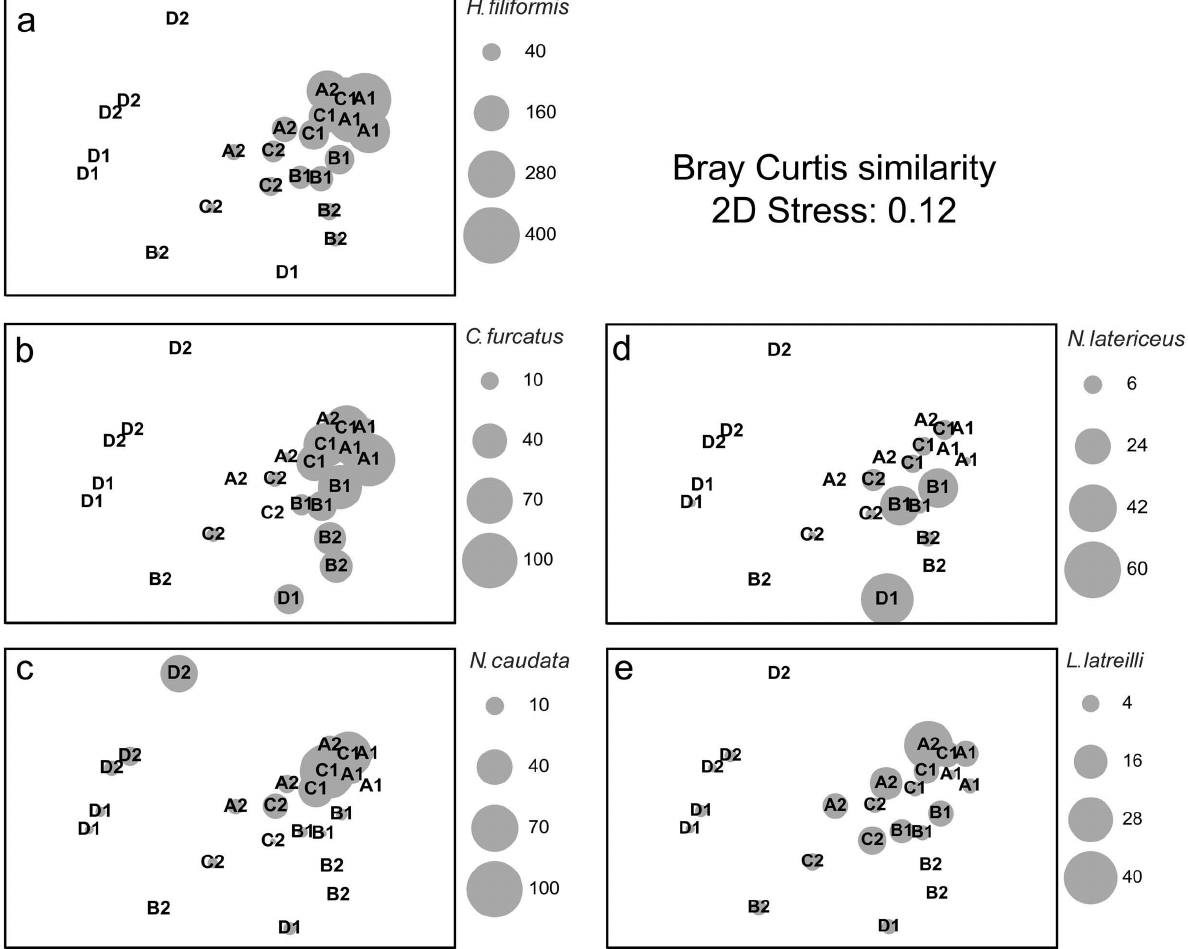
Fig . 4. – nMDS of the polychaete assemblages in July (A1, B1, C1, D1) and January (A2, B2, C2, D2). The abundances of Heteromastus filiformis (a), Cirrophorus furcatus (b), Neanthes caudata (c), Notomastus latericeus (d) and Lumbrineris latreilli (e) are superimposed on the ordination plots. The diameter of bubbles is proportional to the number of individuals per